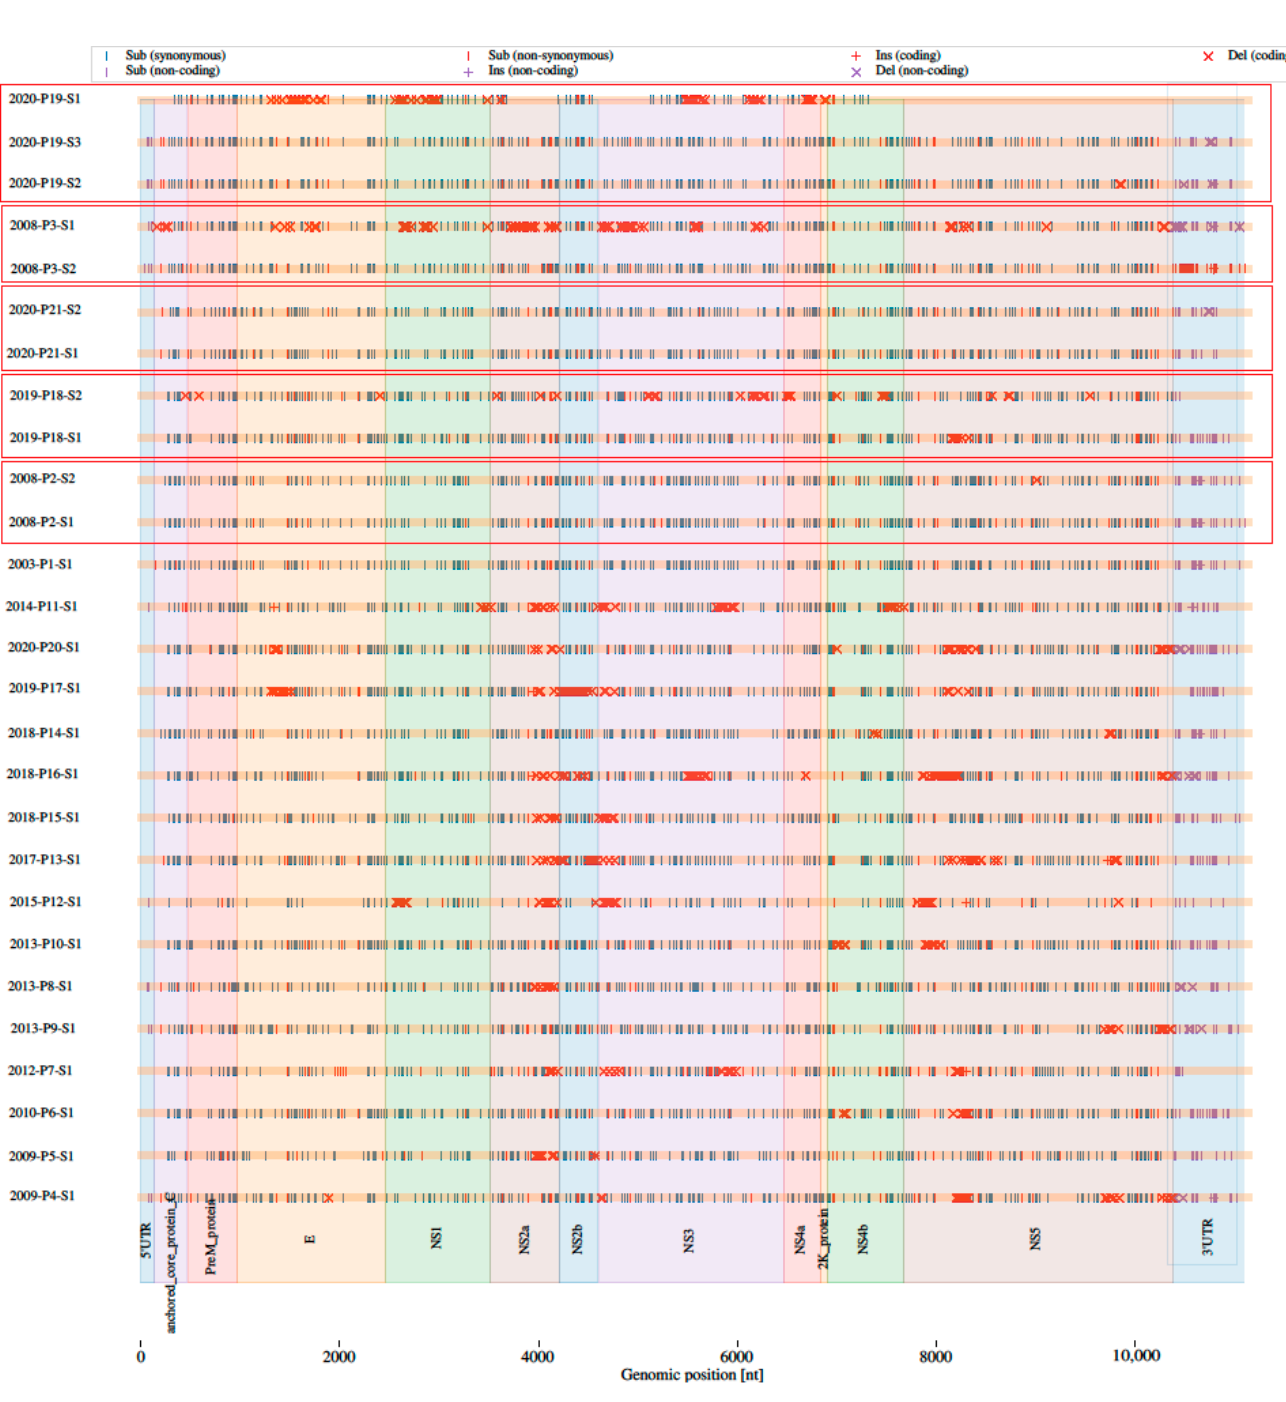
Figure 3. The layout of mutations in sequenced TBEV genomes. Five clinical samples that were sequenced with both approaches and both technologies (shotgun metagenomic sequencing and Oxford Nanopore Technologies) are enclosed in rectangles. Sample ID is composed: year of isolation- patient number–number of an aliquot of the sample used for sequencing.